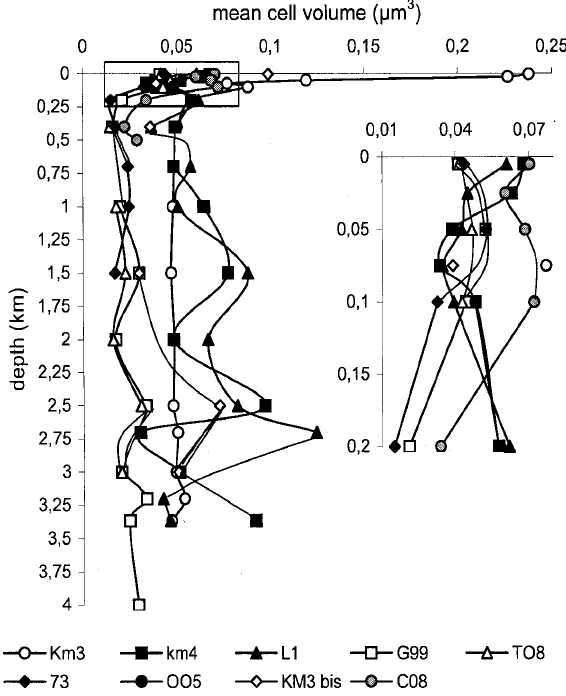
F IG . 3. – Mean cell volumes of the cells from the nine sampling sta- tions. The distribution of cell volumes in the upper 200 m, enclosed on the left within the box, is enlarged on the right side of